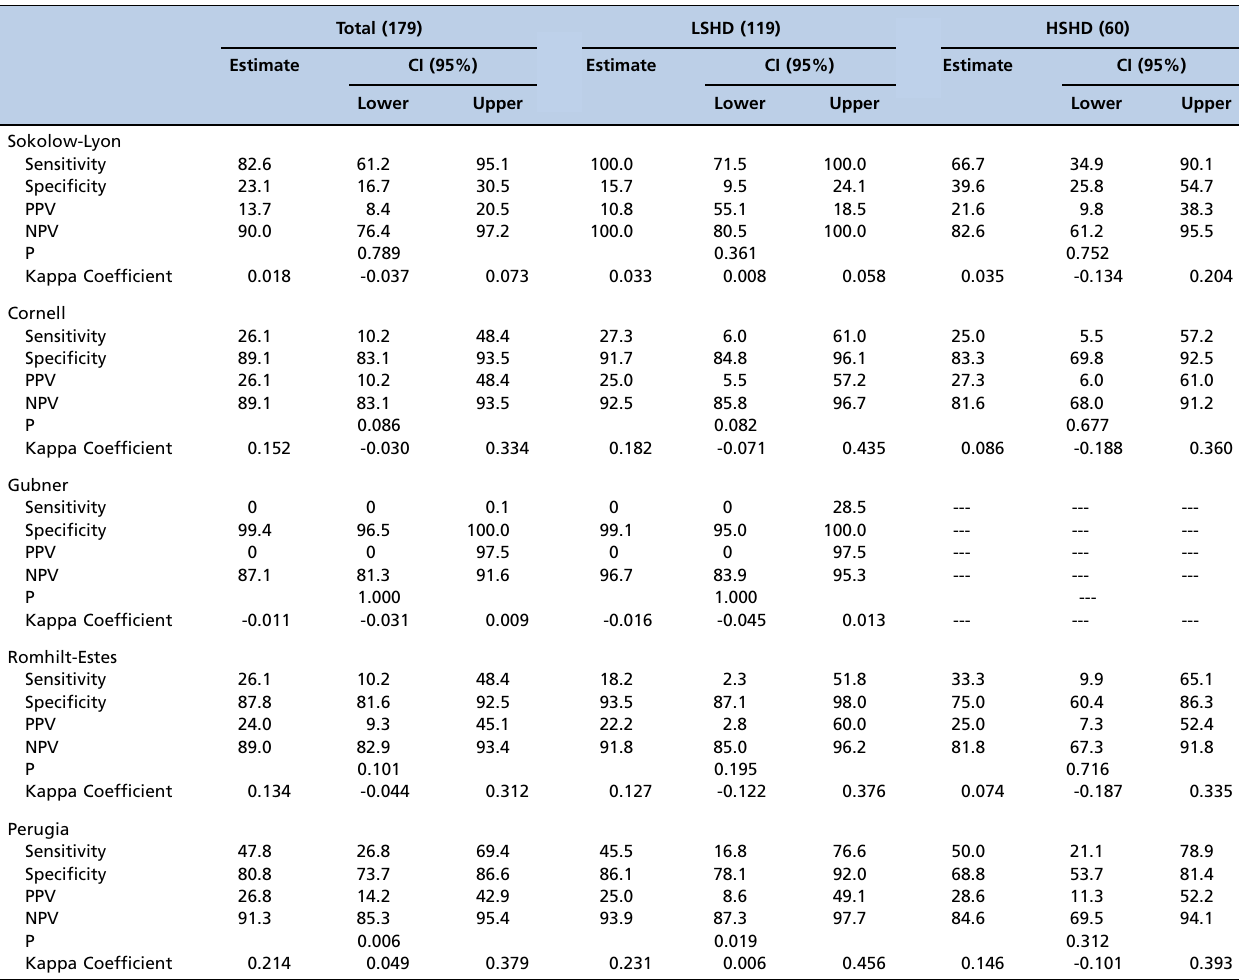
Table 2 - LVMI x Electrocardiogram